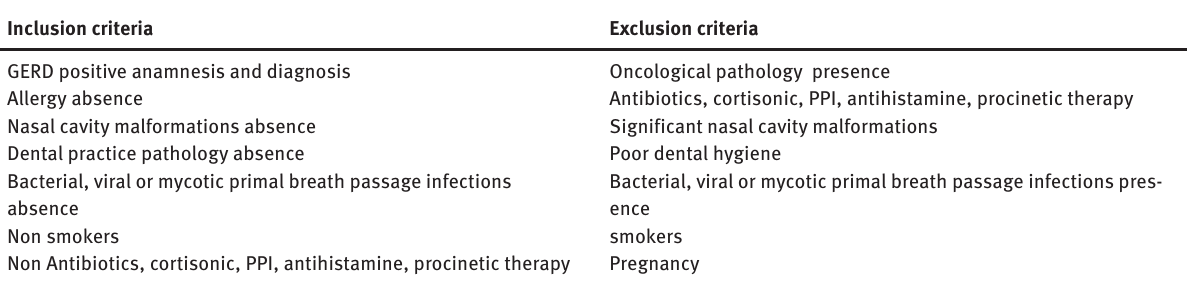
Table 1: Inclusion and exclusion criteria